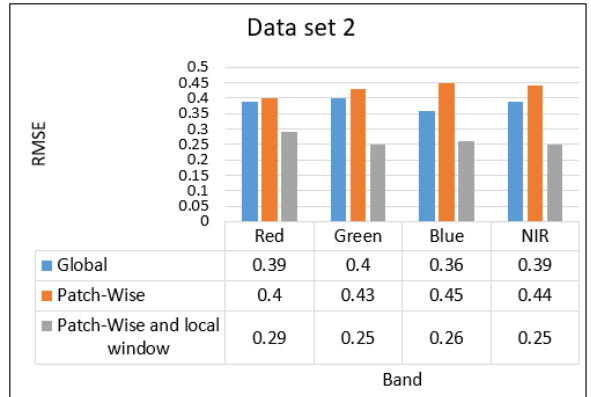
Figure 15. Final accuracy of band to band registration of the 4 bands with the reference of the red-edge band, data set 2